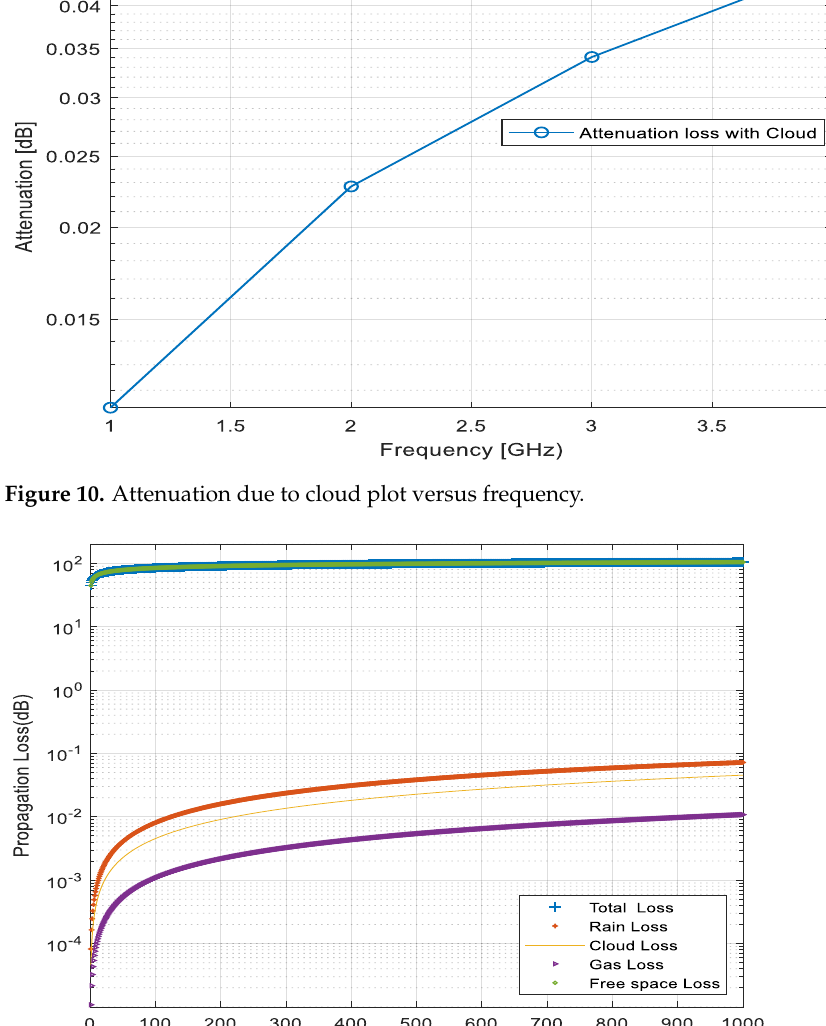
Figure 10. Attenuation due to cloud plot versus frequency.